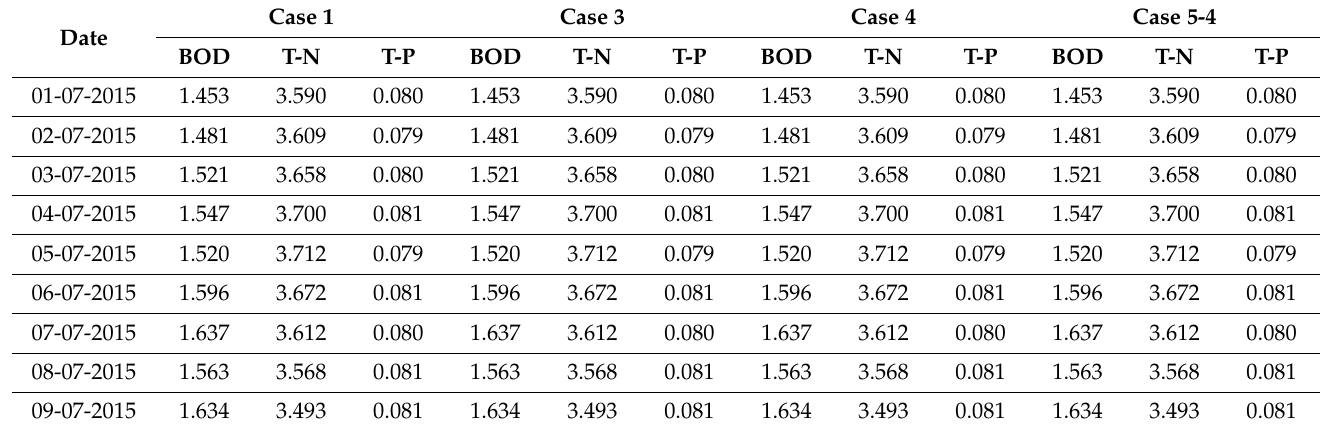
Table 7. Consistency results of major water quality